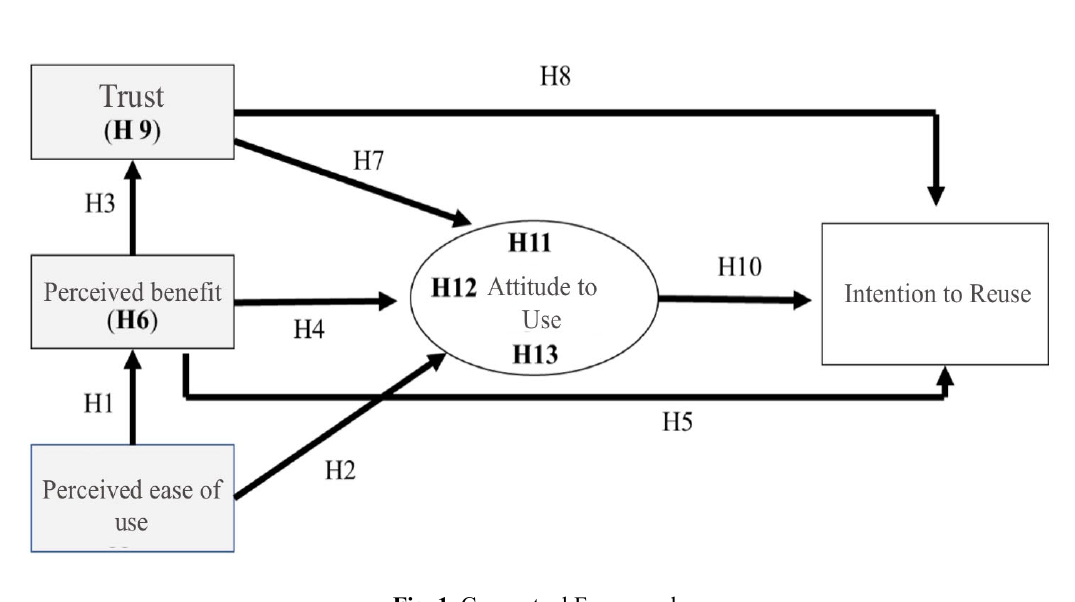
Fig. 1. Conceptual